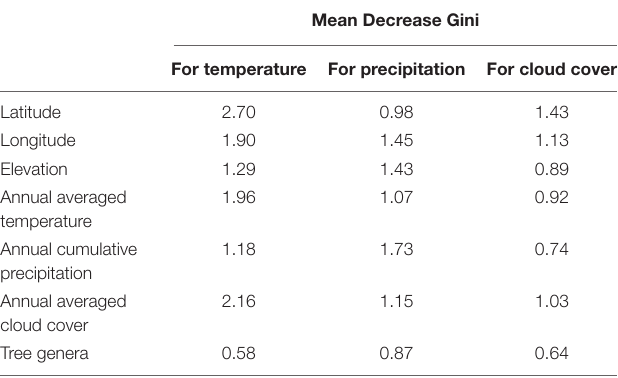
TABLE 4 | Mean Gini coefficient decrease for geographical (latitude, longitude, and elevation), climatological (annual averaged temperature and cloud cover, and annual cumulative precipitation), and biological (tree genus) characteristics in random forest models explaining response function coefficients of the RWI with autumn climate variables.